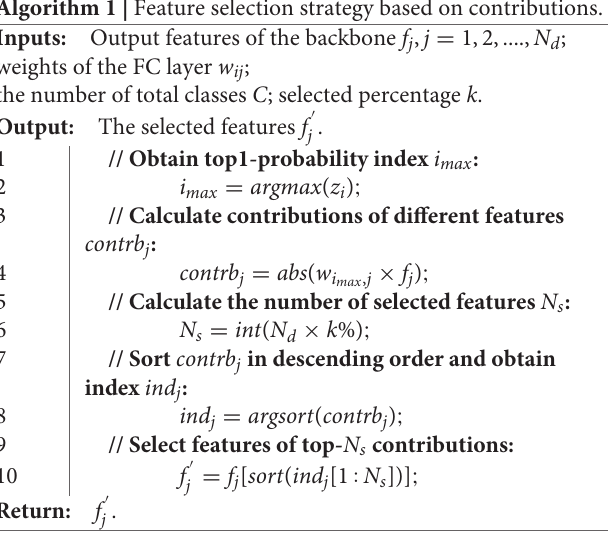
Algorithm 1 | Feature selection strategy based on